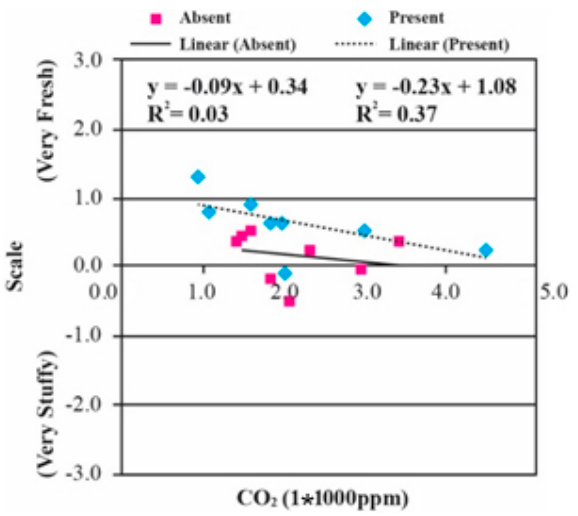
Figure 8. The perception of freshness with or without plant placement.